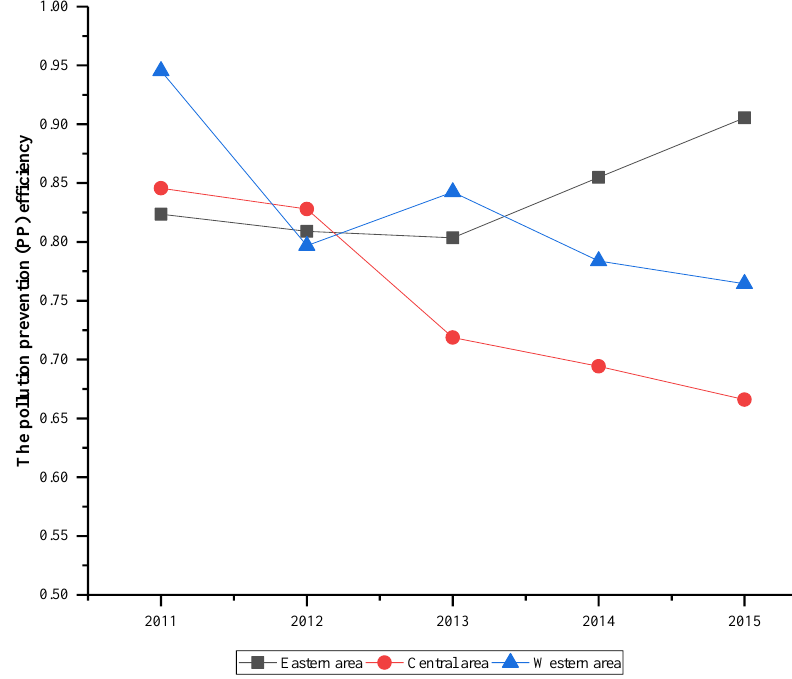
Figure 8. The average PP efficiency of three areas.